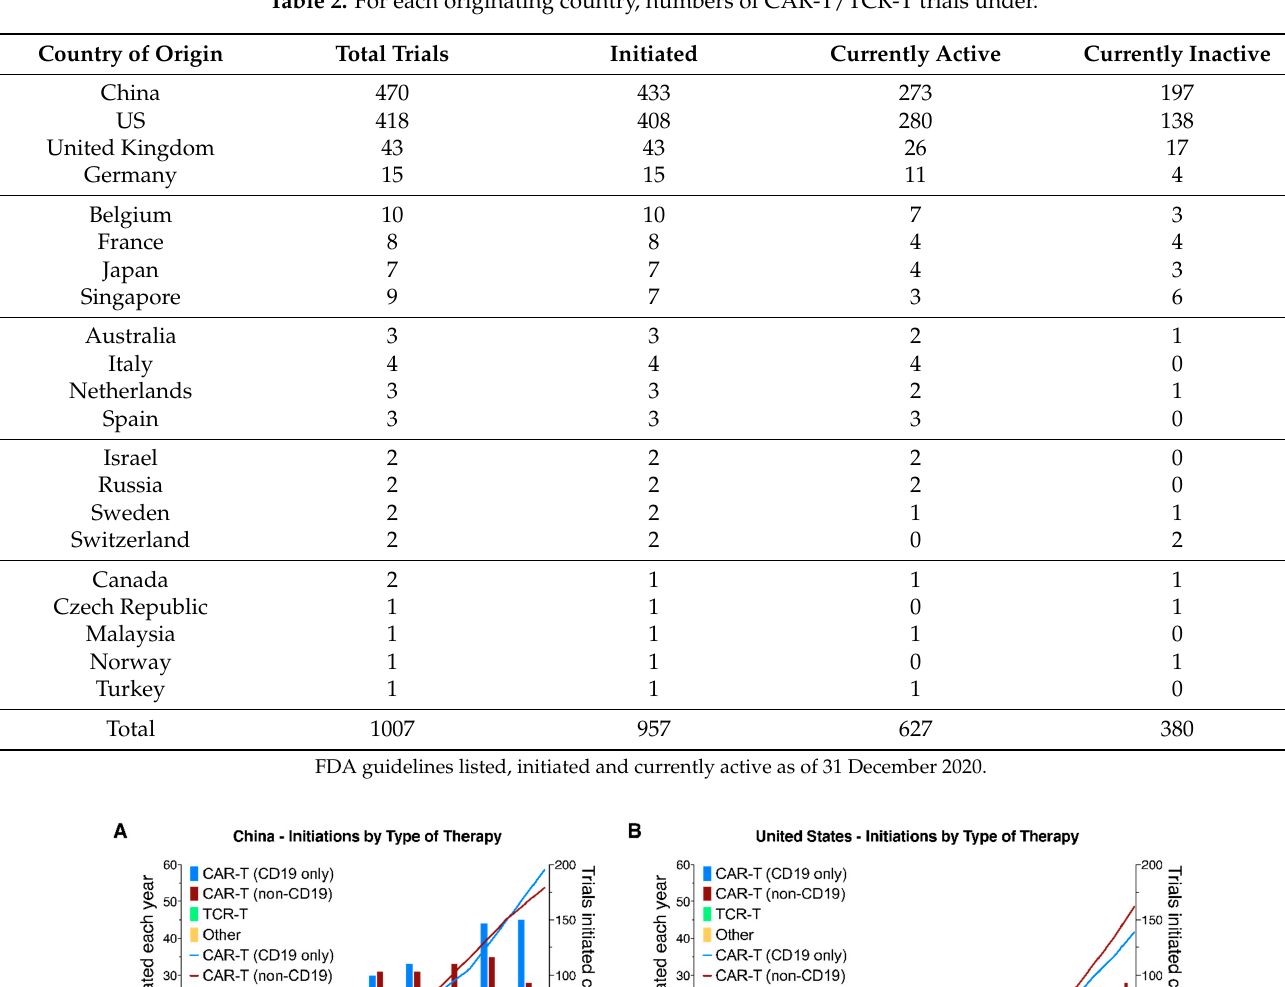
Table 2. For each originating country, numbers of CAR-T/TCR-T trials under.